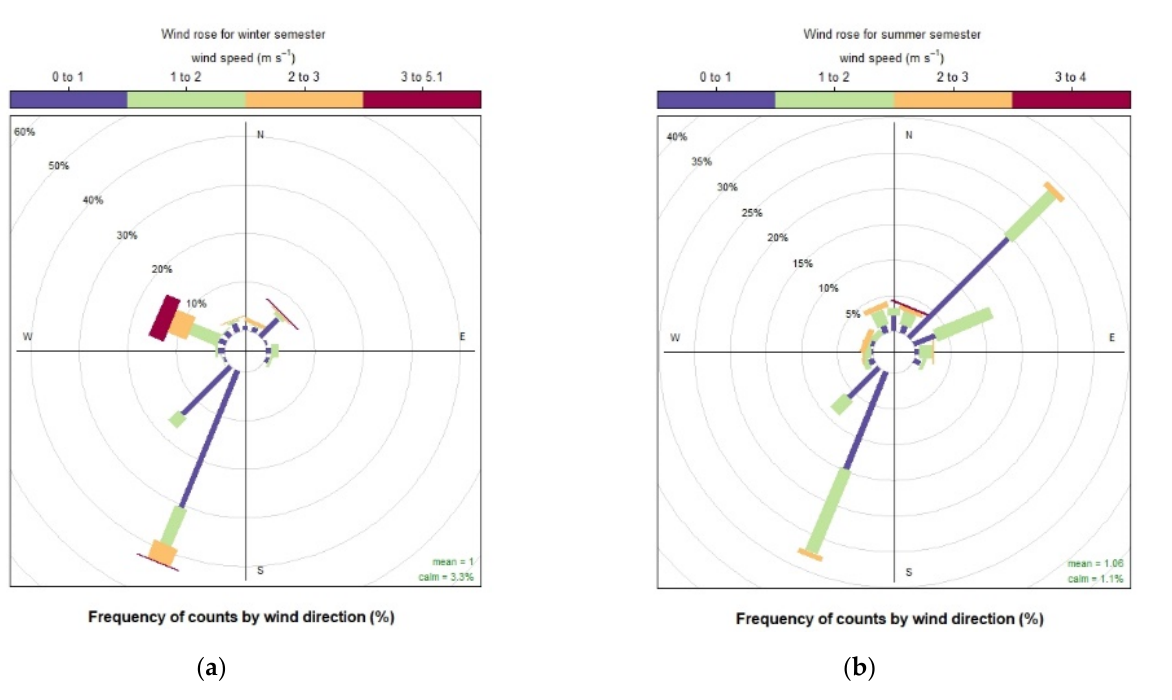
Figure 6. ( a ) Seasonal Windrose (winter semester) for the Pescara weather station, 2017–2018 two- year period. ( b ) Seasonal Windrose (summer semester) for the Pescara weather station, 2017–2018 two-year period.